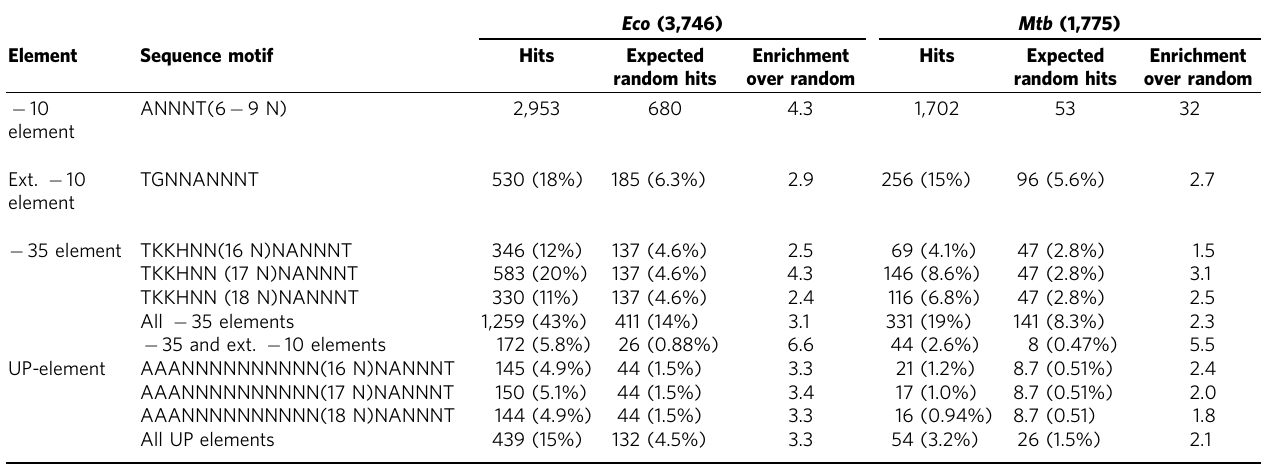
Table 1 | Promoter motifs in Eco and Mtb.